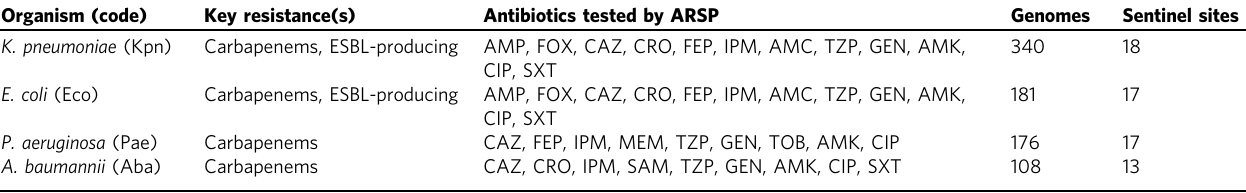
Table 1 Organisms from the retrospective sequencing survey described in this